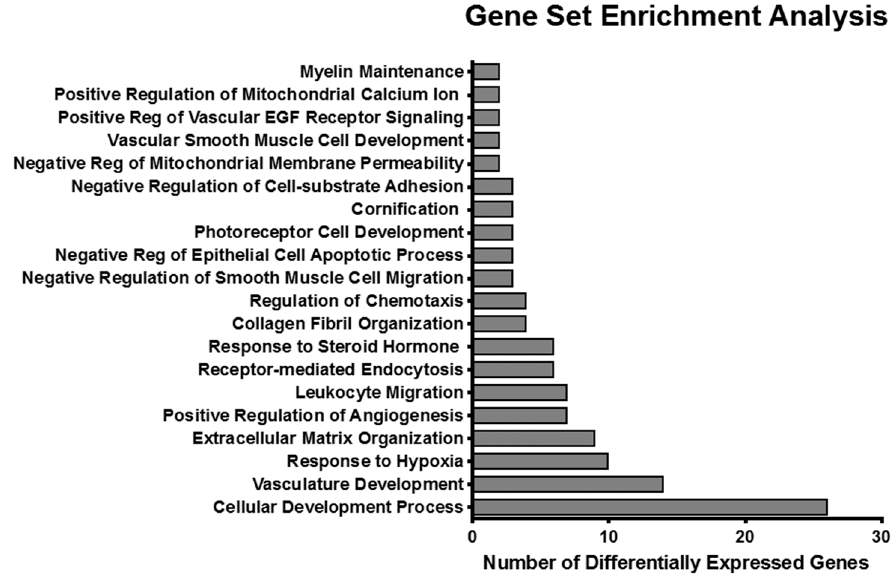
Figure 3. Ketorolac treatment down-regulates gene expression signatures in a mouse xenograft model of ovarian cancer. SKOV3ip xenografts were established, then mice were treated with racemic ketorolac at 1 mg / kg / day oral dosing or placebo for two weeks. Rac1 and Cdc42 activity was decreased by approximately 50% and 35% respectively, similar to what we found in clinical samples [78]. RNA-sequencing was conducted on tumors isolated from mice. Di ff erentially expressed genes were identified using a threshold of > 2-fold change and a false discovery adjusted p -value cut-o ff of 0.05. All genes in this set were down-regulated by ketorolac.